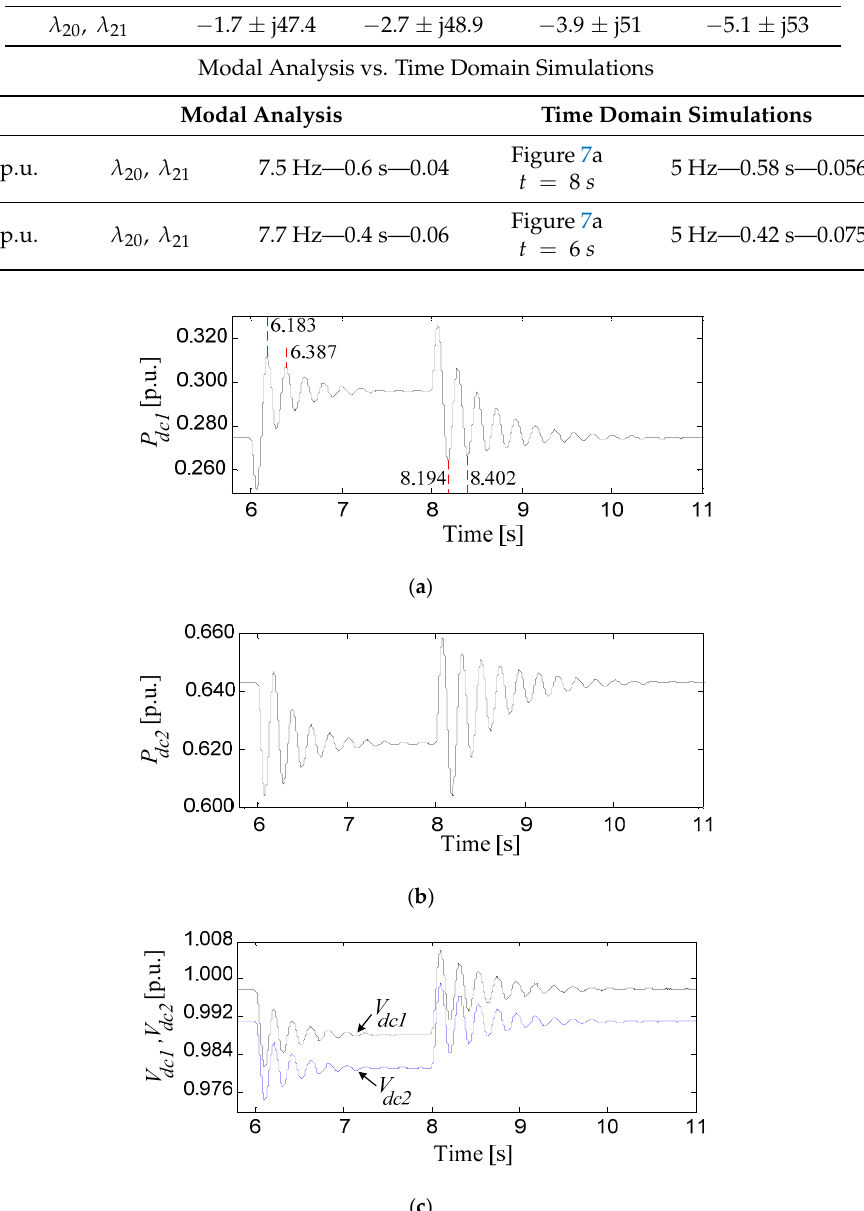
Table 5. Influence of the Static Droop Gains of Both VSRs.